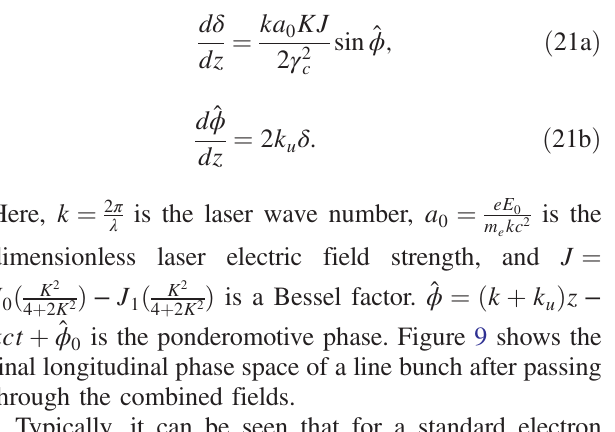
α 0 and λ ¼ 5 cm, U